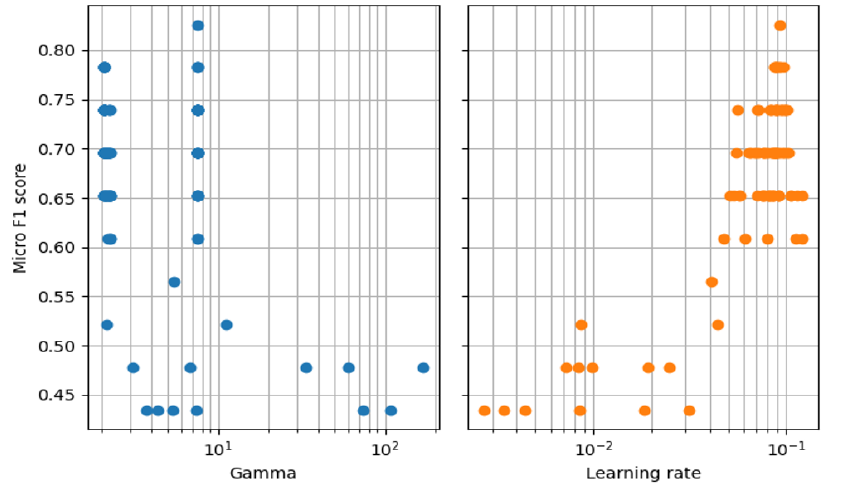
Figure 9. Bayesian optimization results with two free